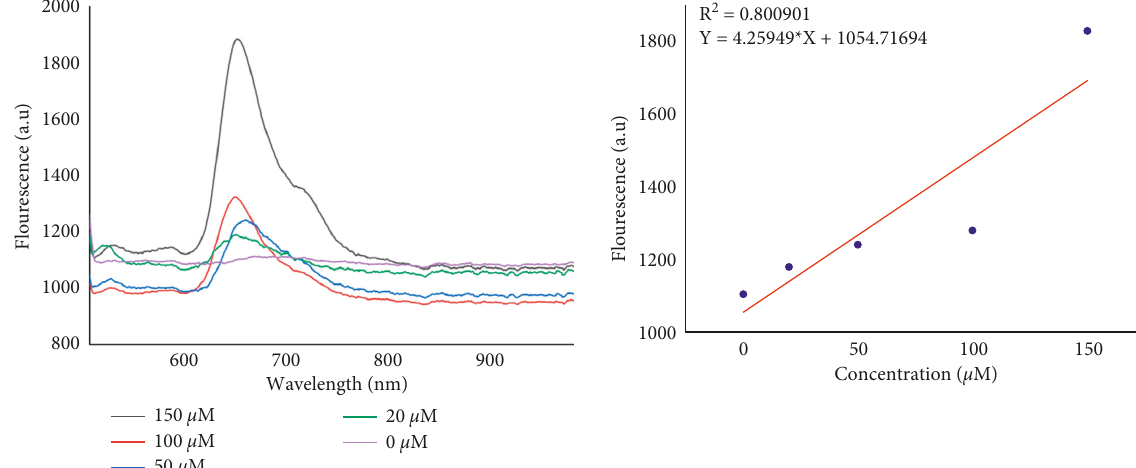
Figure 6: An example of the fluorescence spectra acquired for different concentrations of the photosensitizer in the methanol solvent.